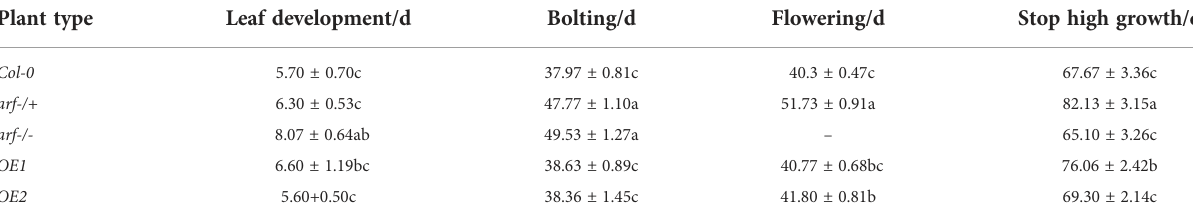
TABLE 4 Phenotypes of transgenic A. thaliana